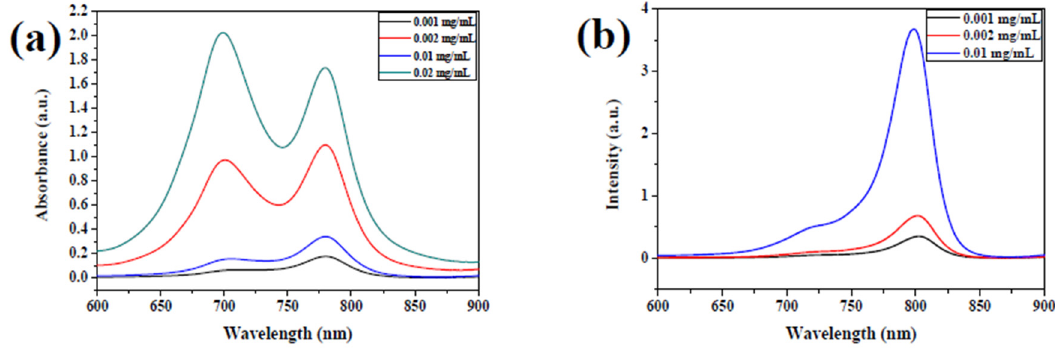
Figure 1. ( a ) Absorbance spectra of NIR 800 at different concentrations in buffer solution (pH = 8.0); ( b ) absorbance spectra of NIR 800 at different concentrations in DMF.